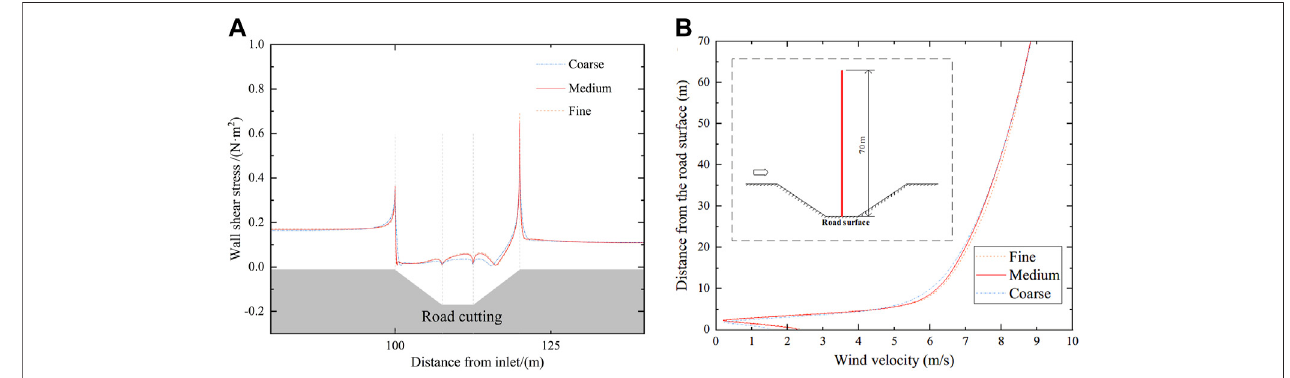
FIGURE6| Gridsensitivitytestresults.Toillustratethegridquantityofthenumericalmodelissuf fi cientinthisstudy,thegridindependencetestwascarriedout. (A) comparison of the wall shear stress near the cutting under different cases. (B) comparison of wind speeds within a height range of 70 m. The results show that both accuracy and computational costs are considered in the grid in this study.